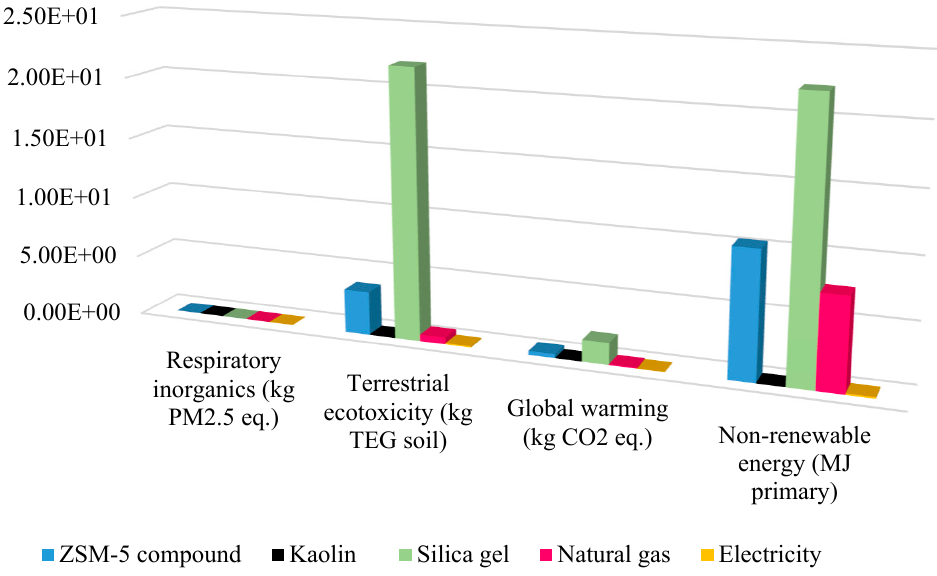
Figure 6. Contribution of the ZSM-5 catalyst production processes in selected impact categories.